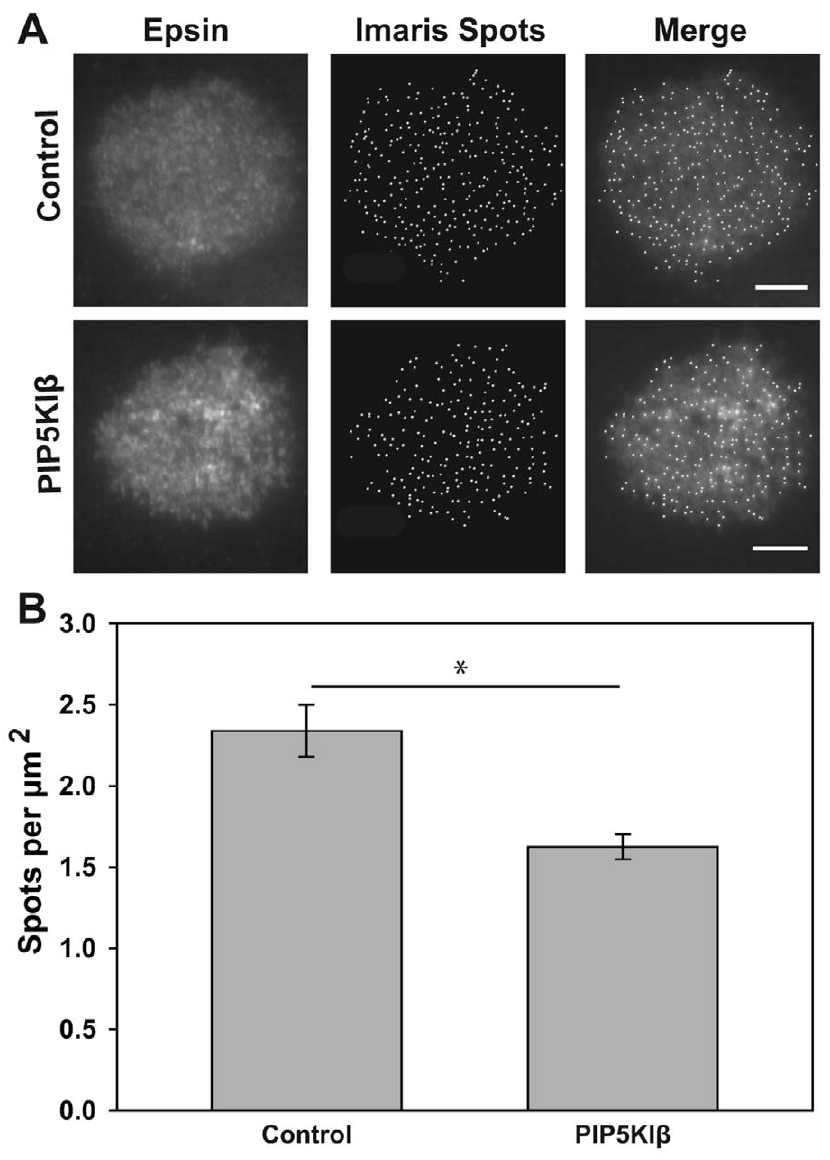
Figure 8. There are fewer apical CCPs in MDCK cells overexpressing PIP5KI b . MDCK cells were cultured on permeable supports and co- infected with adenovirus encoding epsin-GFP and either PIP5KI b or control virus. Filters were fixed and processed to detect HA-tagged PIP5KI b in order to determine which cells were overexpressing the kinase, then mounted in PBS for TIRF microscopy. (A) TIRF images of epsin-GFP in control and PIP5KI b overexpressing cells are shown with corresponding detection of spots by Imaris. Scale bar: 5 m m. (B) Imaris analysis of TIRF data (n=23 cells from three experiments) indicates that there is a decrease in epsin spots per square micron upon over expression of PIP5KI b . Student’s t-test was performed to assess statistical significance (*p ,